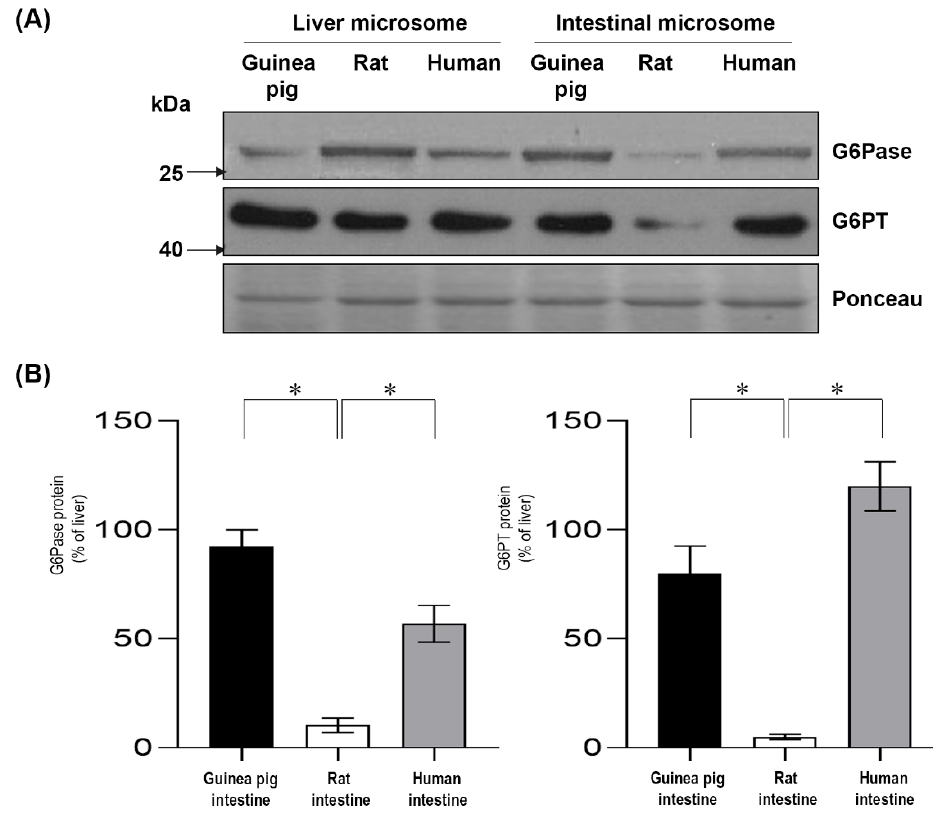
Figure 4. Analysis of the protein expression of glucose-6-phosphatase and glucose-6-phosphate transporter in guinea pig, rat and human intestinal microsomes. Microsomal proteins from these species were prepared for Western blot analysis ( A ). The figure shows a representative image from three separate experiments. Samples were immunoblotted with anti-glucose-6-phosphatase and anti-glucose-6-phosphate transporter antibodies. Ponceau staining was used as a loading control. Western blot images were quantified, and the expression levels of the examined intestinal proteins are shown in the percentage of liver expression ( B ). Bars display mean ± SEM, and statistical analysis was performed using a one-way ANOVA with a Tukey post hoc test with p = 0.05–0.01 *, p = 0.01–0.001 **, and p ≤ 0.001 ***. G6Pase = Glucose-6-phosphatase; G6PT = Glucose-6-phosphate transporter.